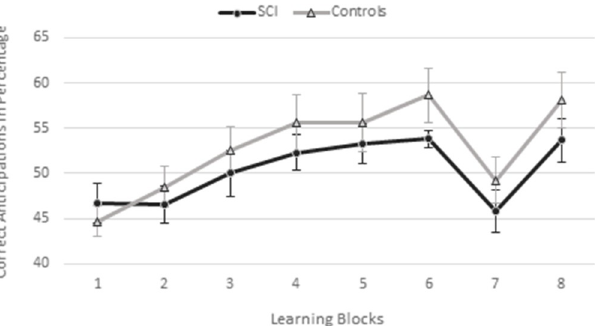
Fig 3. Ocular activated serial reaction time task anticipation scores (mean and SEM) in the spinal cord injury (SCI) and control groups.